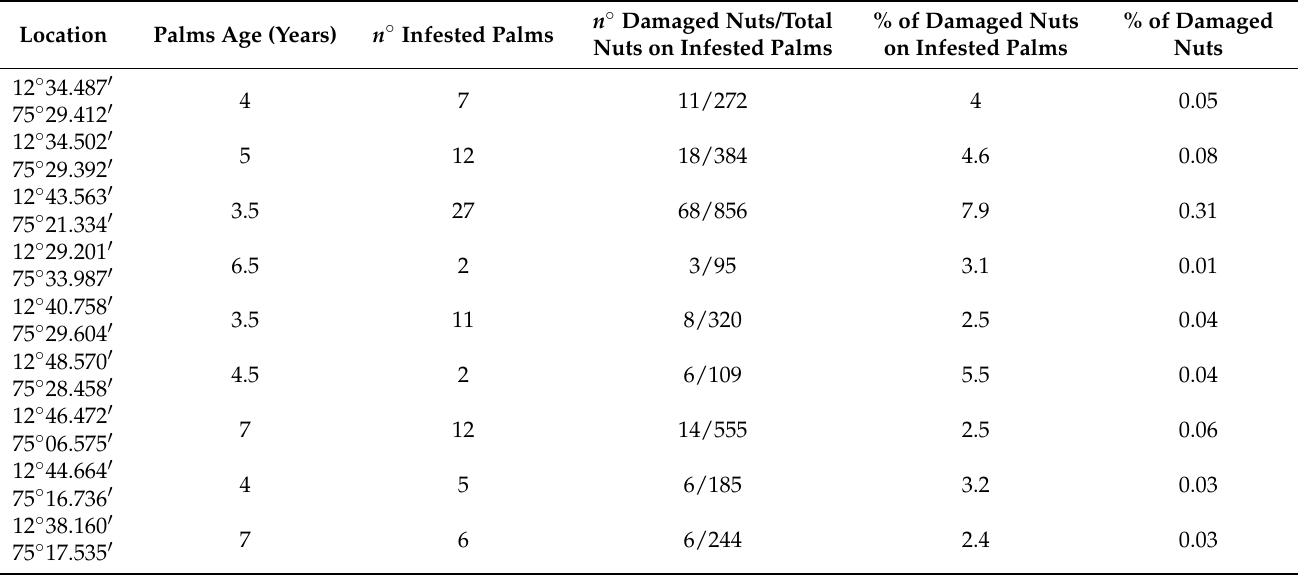
Table 1. Localities where X. crassiusculus attacks were recorded during the survey in association with damage